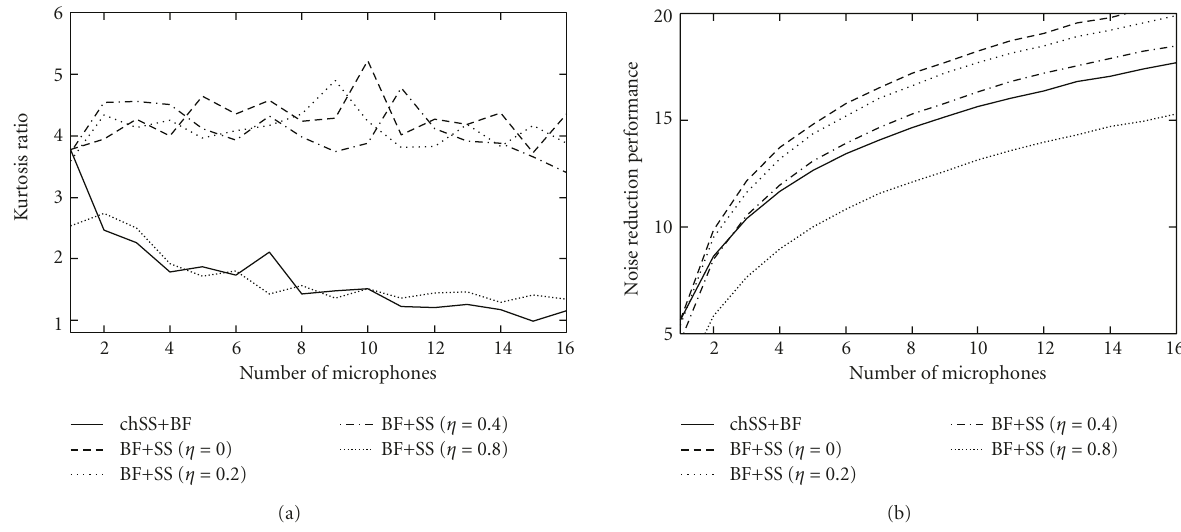
Figure 18: Results for super-Gaussian input signal. (a) Kurtosis ratio and (b) noise reduction performance for BF+SS with various flooring parameters.